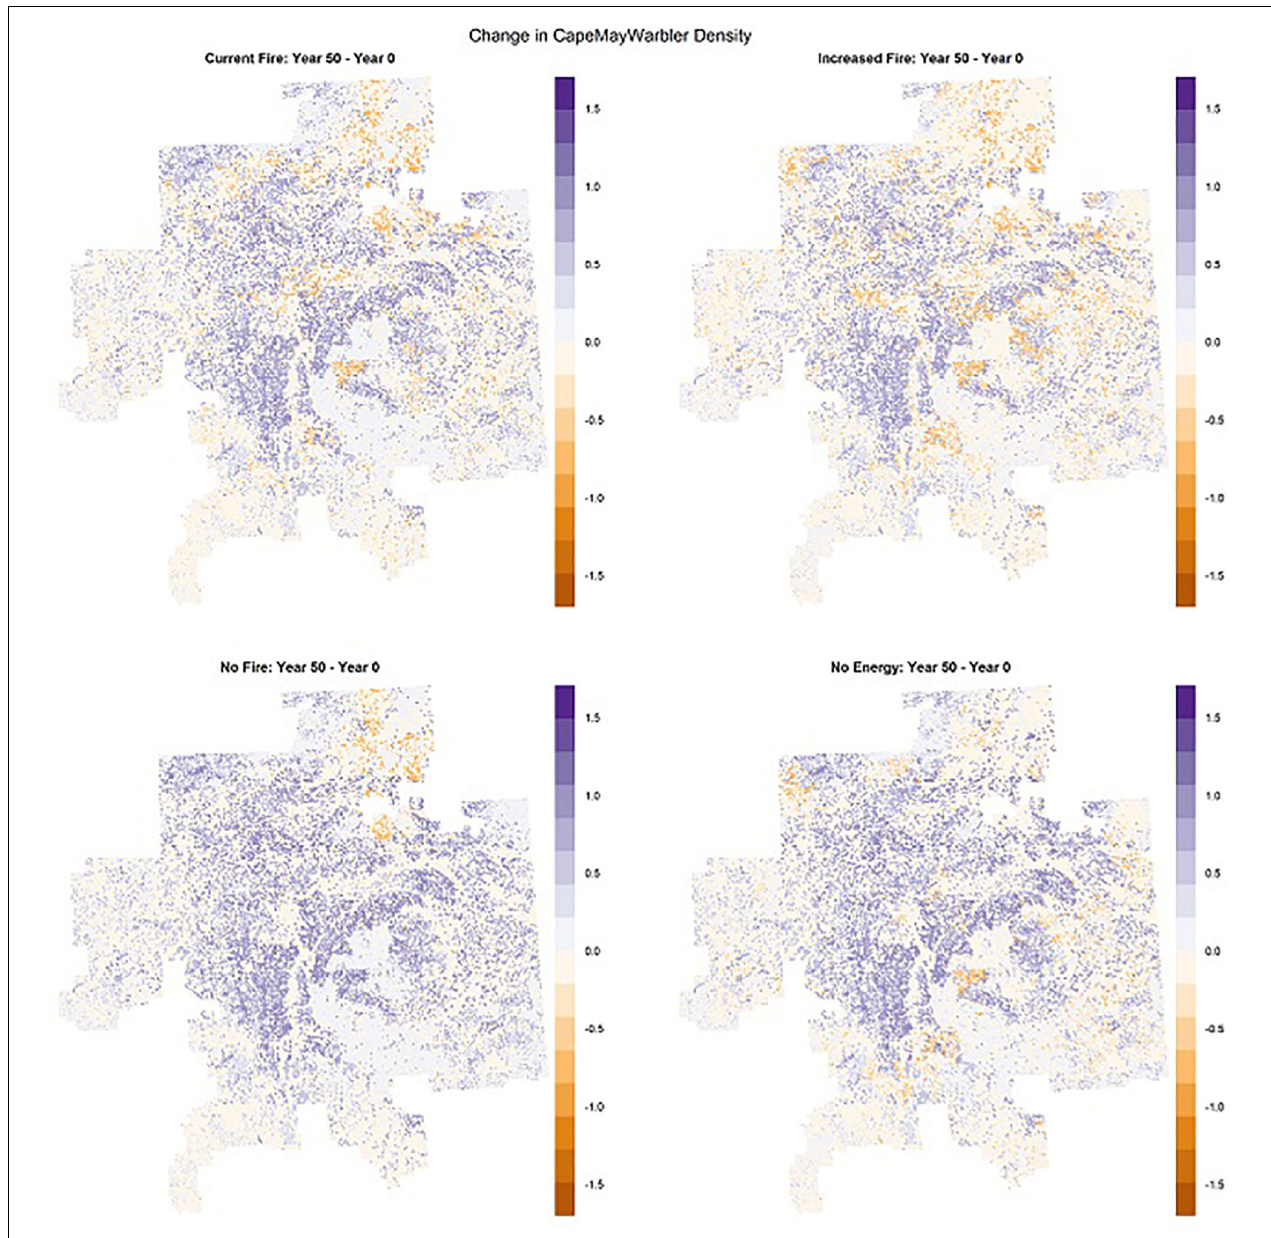
FIGURE 11 | Mean density (#birds/ha) and distribution of Cape May Warbler – a songbird that responded negatively to fire and energy sector development - in the Al-Pac Forest Management Area (FMA) under four cumulative effects scenarios in ALCES Online: (1) harvest from the Preferred Forest Management (PFM) scenario + current burn rate + moderate energy sector development over 50 years (“Al-Pac BAU” scenario) (top left) ; (2) harvest from the PFM scenario + 2*current burn rate + moderate energy sector development over 50 years (“Increased Fire” scenario) (top right) ; (3) harvest from the PFM scenario + no fire + moderate energy sector development over 50 years (“No Fire” scenario) (bottom left) ; (4) harvest from the PFM scenario + current burn rate + no energy sector development over 50 years (“No Energy” scenario) (bottom right)